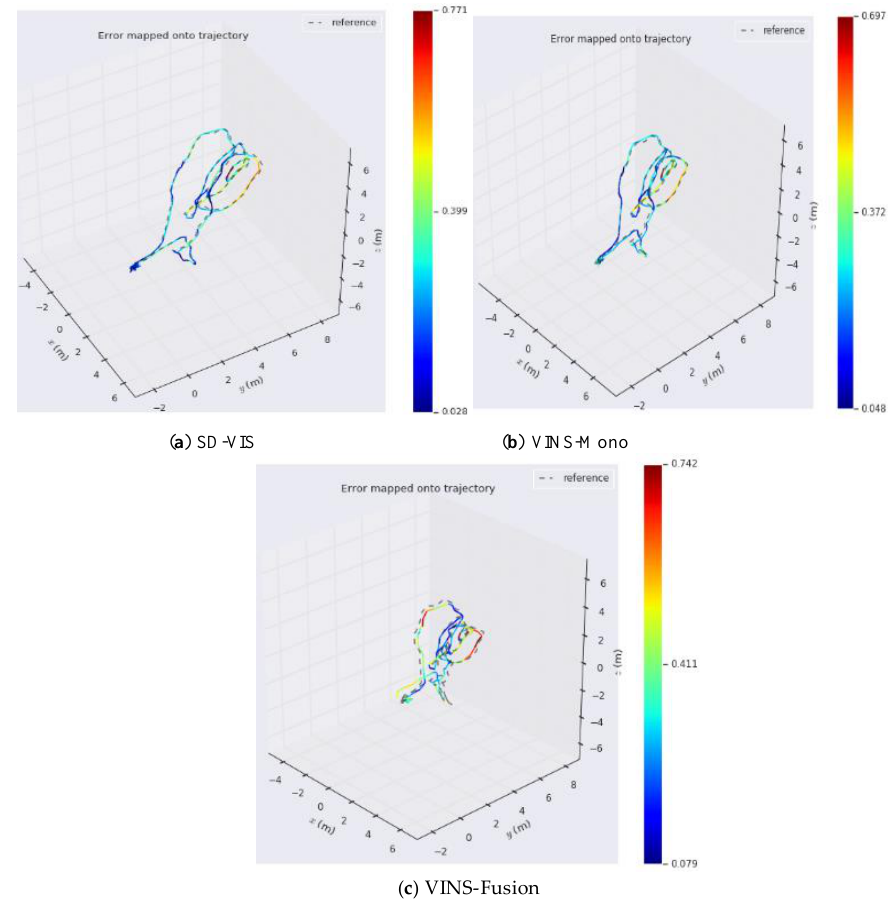
Figure 7. The trajectory heat map estimated by SD-VIS, VINS-Mono, and VINS-Fusion in MH_01_easy.